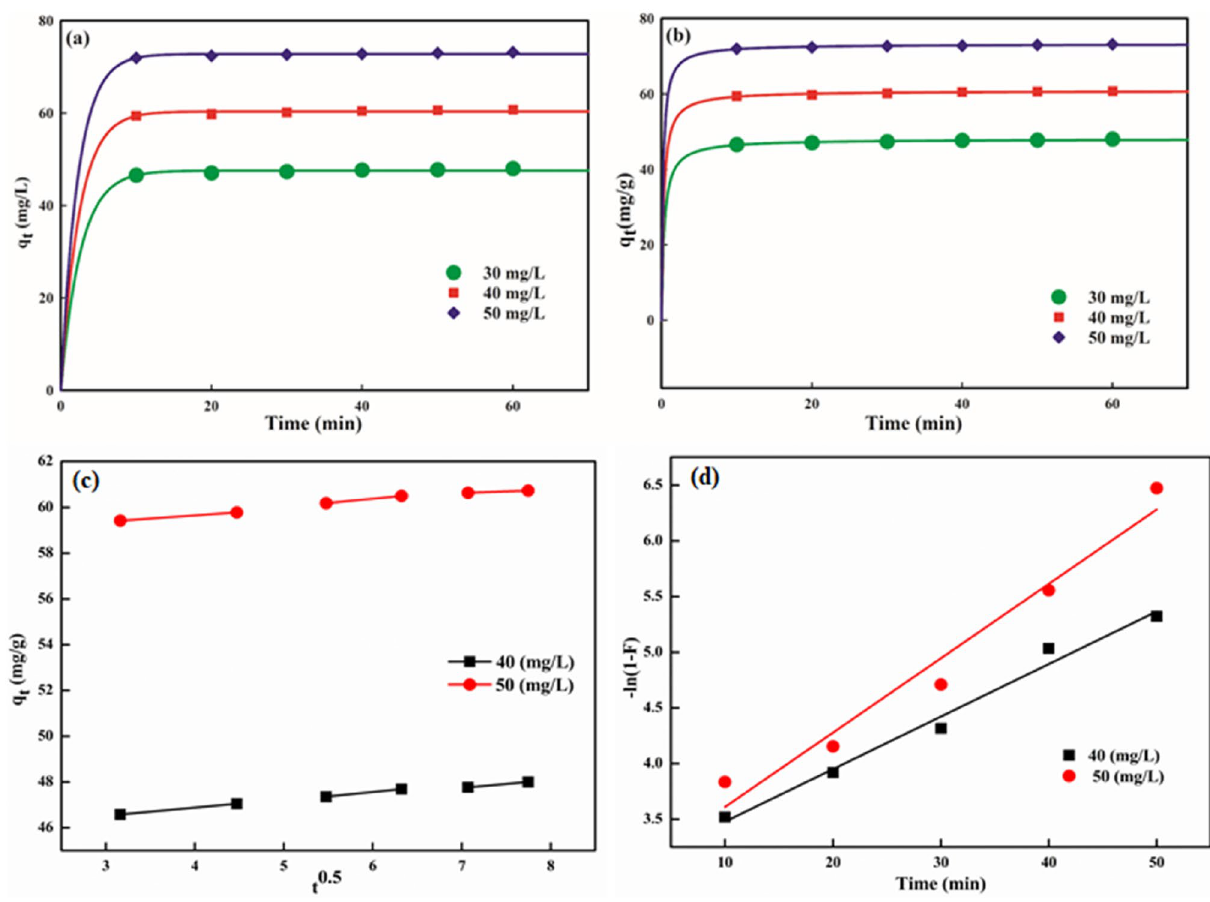
Figure 7. Kinetic plots: ( a ) pseudo-first order, ( b ) pseudo-second order, ( c ) intraparticle diffusion, and ( d ) liquid film diffusion for NB removal.